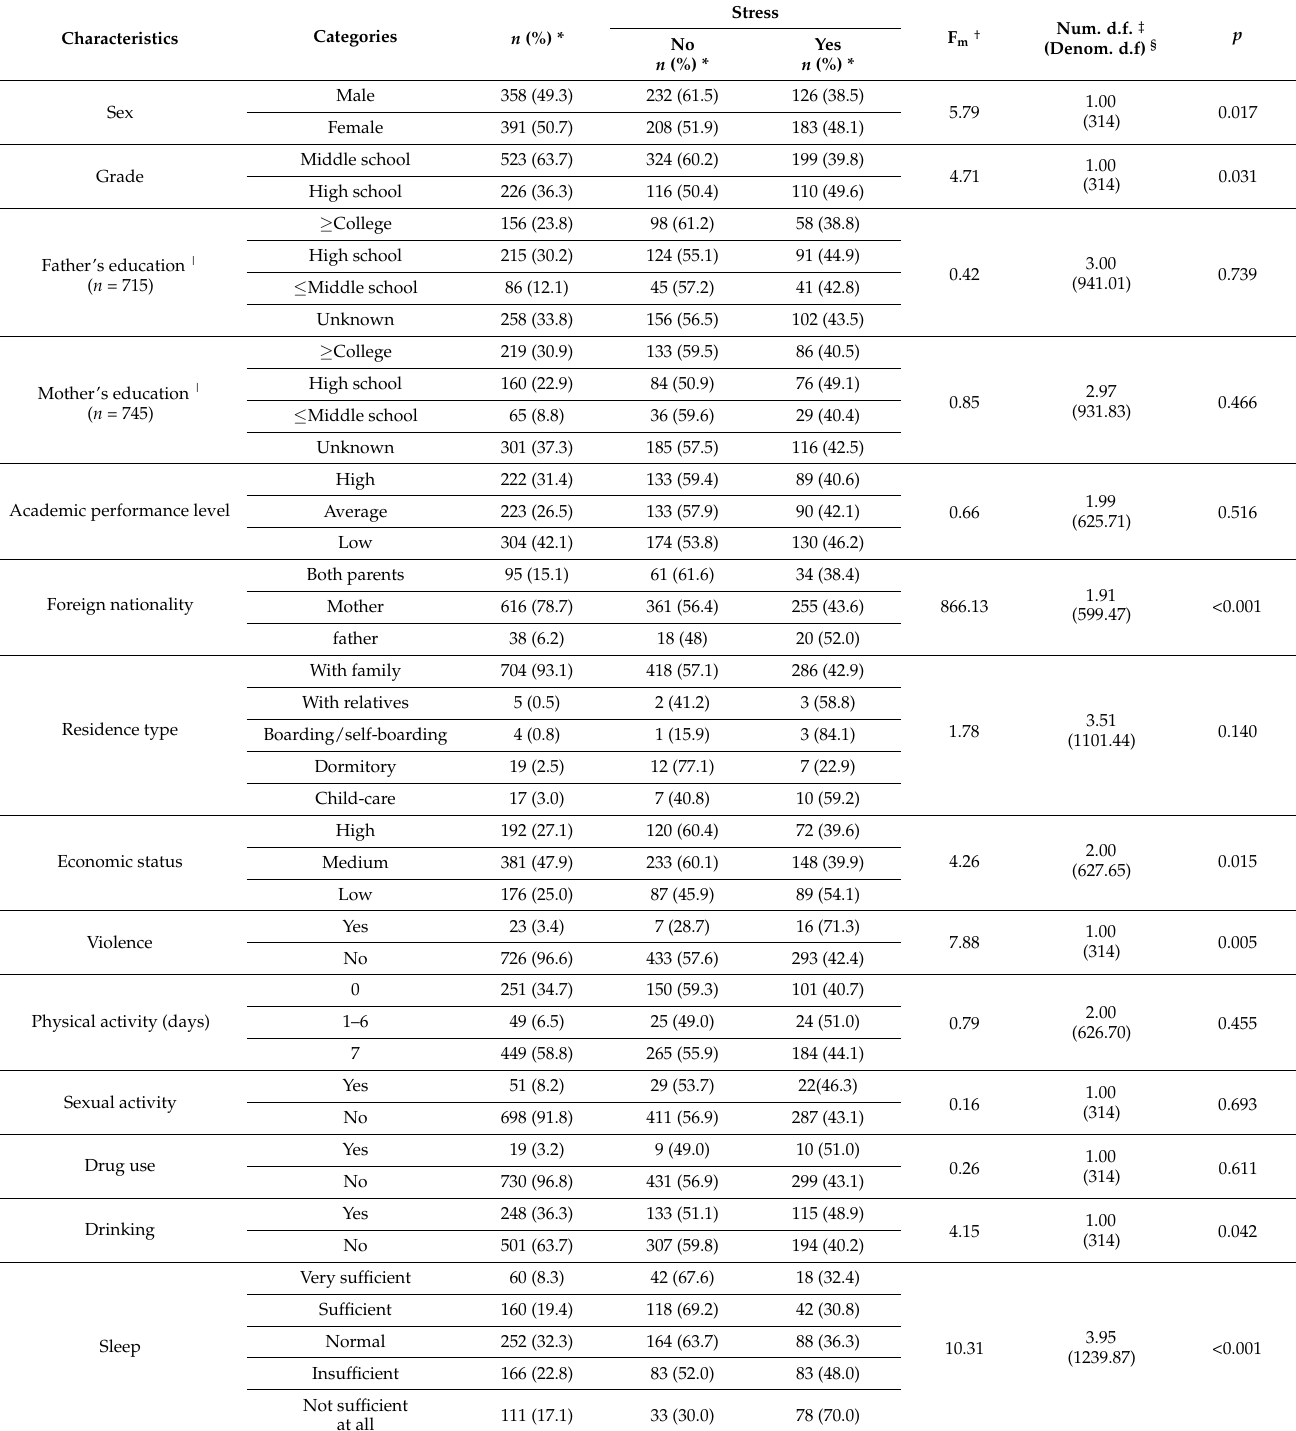
Table 1. Differences in stress according to multicultural adolescents’ general characteristics, health risk behaviors, and mental health ( n =